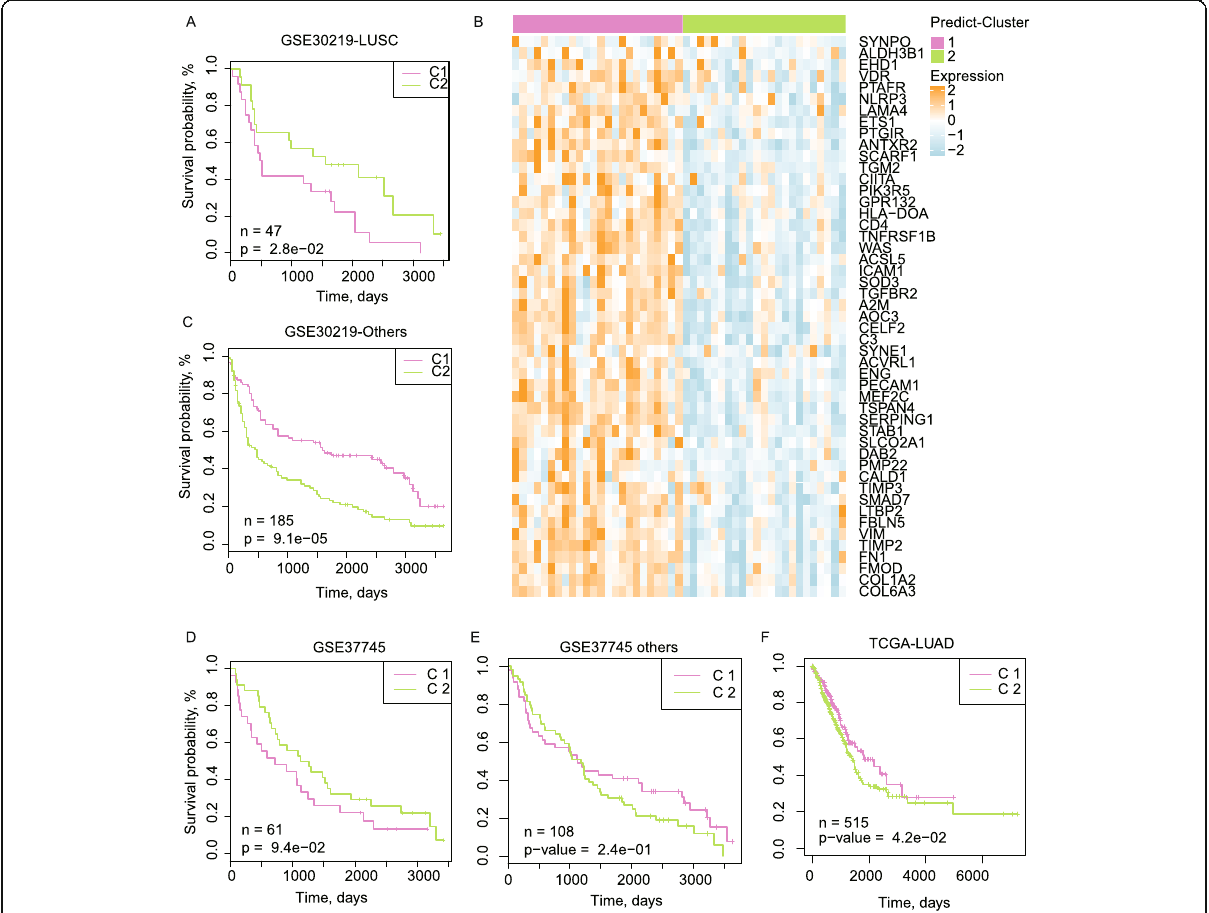
Fig. 5 Validation of the two clusters by an independent lung cancer dataset. a - b . KM plots of the survival curves for two predicted patient clusters in GSE30219 where only LUSC patients ( a ) or the other types of lung cancer patients ( b ) were taken into consideration. c . Expression profiles of the important genes. d - e . KM-plots of the survival curves for two predicted subtypes in GSE37745 where only LUSC patients ( a ) or the other types of lung cancer patients were considered. ( f ) KM-plots of the survival curves for two predicted subtypes in the TCGA-LUAD